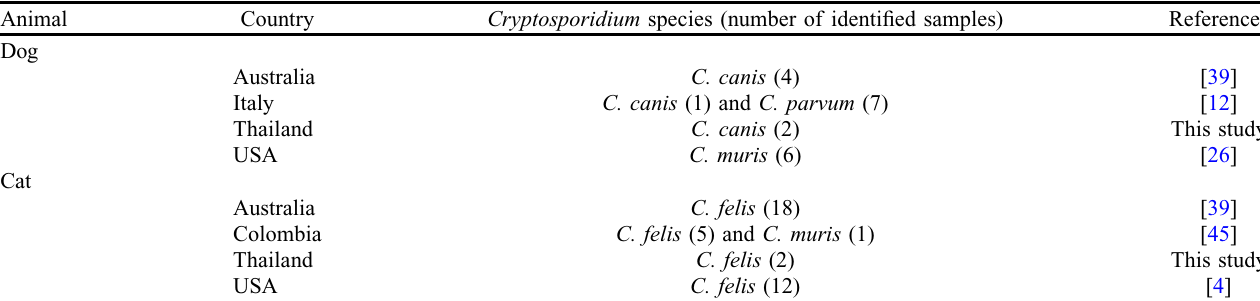
Table 3. Country and Cryptosporidium species for dogs and cats, from published records. Animal Country